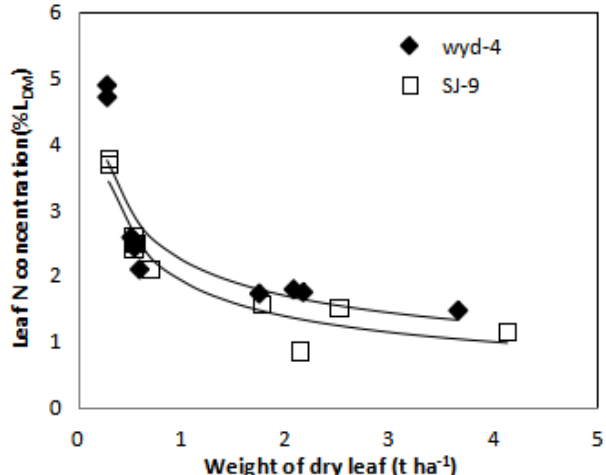
Figure 4. Critical nitrogen (N c ) data points and critical N dilution curves obtained by non-linear fitting for two rice cultivars (Wuyoudao4 N c = 1.96L DM−0.56 and Songjing9, N c = 1.99L DM−0.44 ) under different N application rates in experiments conducted in 2016 and 2017.